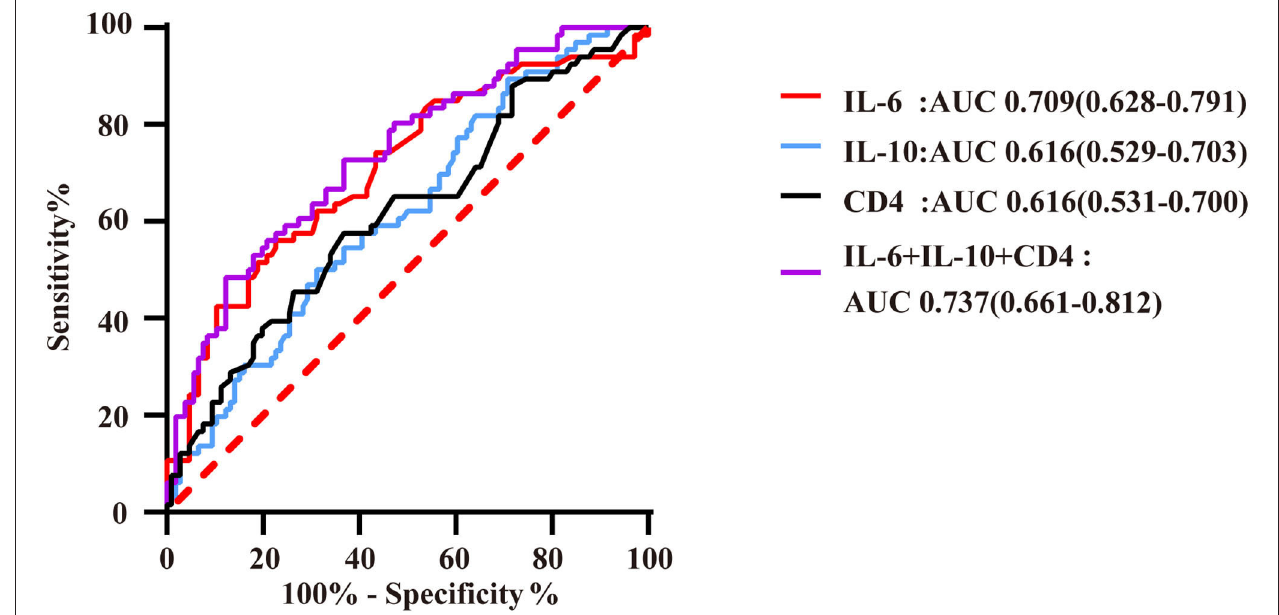
FIGURE 3 | ROC curves of immunoinflammatory biomarkers predicting QFR ≤ 0.8 of the target vessel. AUC indicates the area under the ROC curve. The red curve represents the ROC curve of IL-6; the blue curve represents the ROC curve of IL-10; the black curve represents the ROC curve of CD4 + lymphocytes; and the purple curve represents the ROC curve of markers of immunoinflammatory